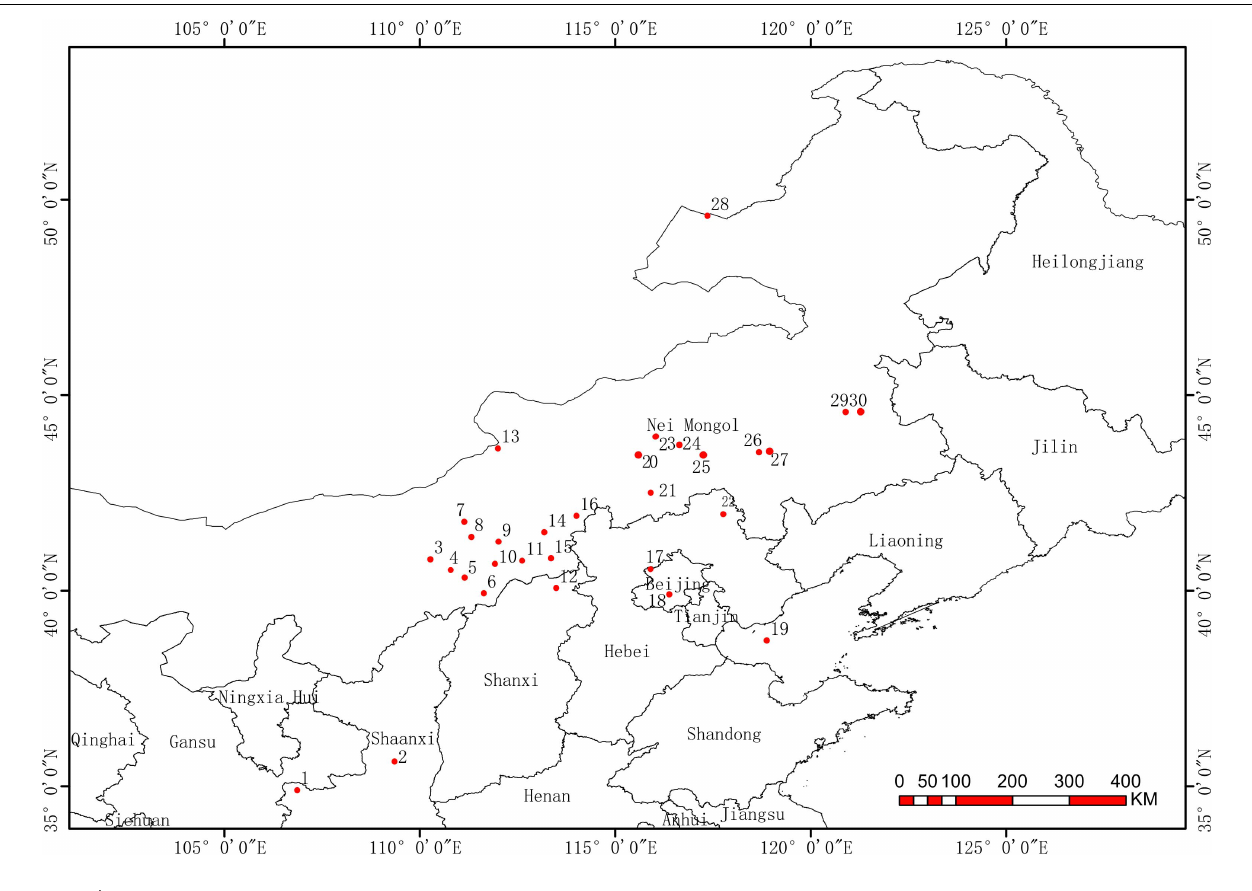
FIGURE 1 | The original locations of 30 Medicago ruthenica